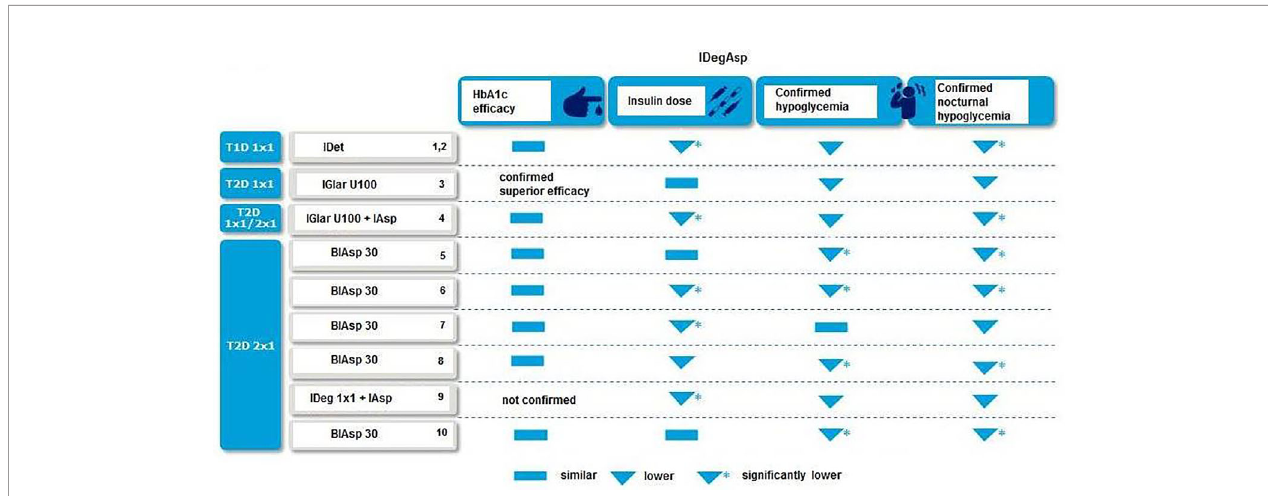
FIGURE 1 | IDegAsp vs. other insulin regimens in clinical trials 1(31); 2(32); 3(33); 4(52); 5(34); 6(35), 7(36); 8(53); 9(38);